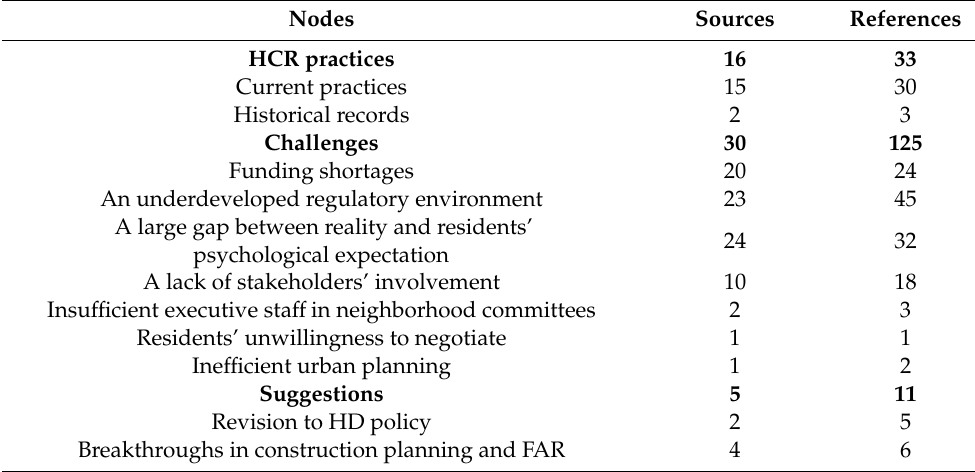
Table 3. Nodes after coding the first-hand